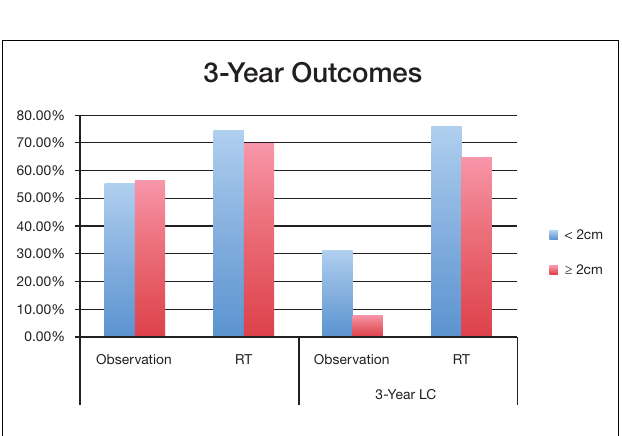
FIGURE 3 | Overall survival and local control of different tumor sizes between observation and postoperative radiation therapy cohort . Abbreviations: observation, surgery only treatment group; RT, received postoperative radiation therapy; OS, overall survival; LC, local